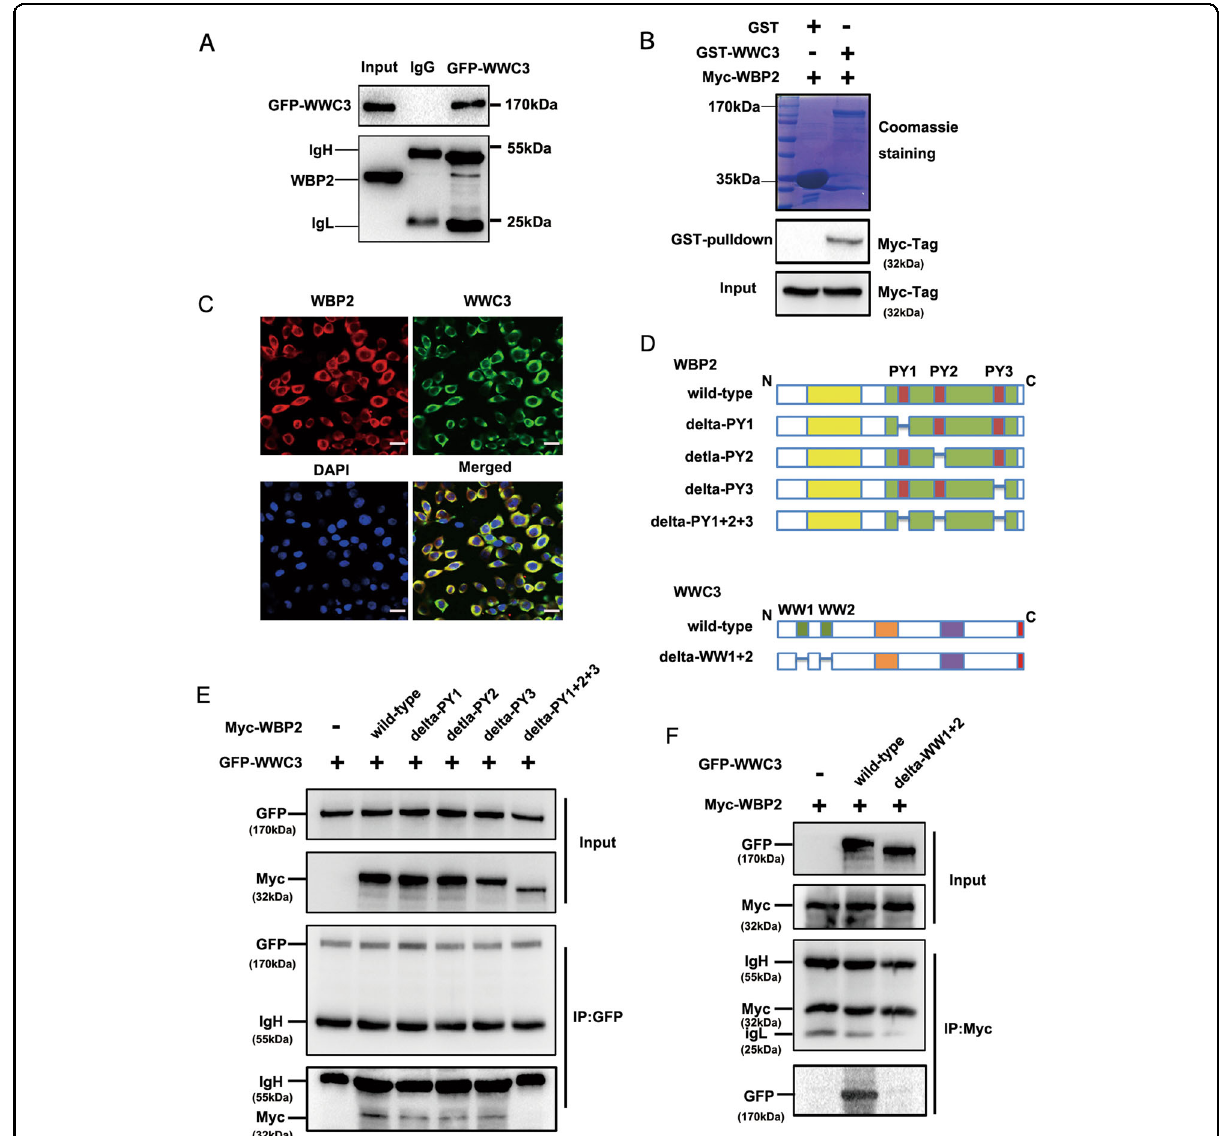
Fig. 5 WBP2 interacts with the WW domain of WWC3 via PPxY motifs. A GFP-WWC3 was transfected into H1299 cells, and after 48 h, the cells were collected and lysed. A GFP monoclonal antibody was used for pulldown. The presence of WBP2 in the precipitate was detected by western blot analysis using a WBP2 antibody. B After incubation with puri fi ed GST or GST coupled-WWC3 protein for 6 h at 4° C, the binding status of two proteins was examined using Coomassie brilliant blue staining and western blot analysis. GST, glutathione-S-transferase. C Immuno fl uorescence assay results indicate that WBP2 and WWC3 colocalize within the cytoplasm of A549 cells. Magni fi cation: ×400, scale bar: 50 μ m. D Schematic diagram of WBP2 and WWC3 splicing mutants. E GFP-WWC3 and Myc-WBP2 wild-type or a series of mutants were co-transfected into H1299 cells. After 48 h, the cells were collected and lysed. GFP antibody was used for precipitation, and the presence of WBP2 was detected by immunoblotting using a Myc antibody. F Similarly, Myc-WBP2 and GFP-WWC3 wild-type or GFP-WWC3- △ WW mutants were co-transfected into H1299 cells. GFP antibody was used for precipitation, and the presence of WBP2 was detected by immunoblotting using a Myc